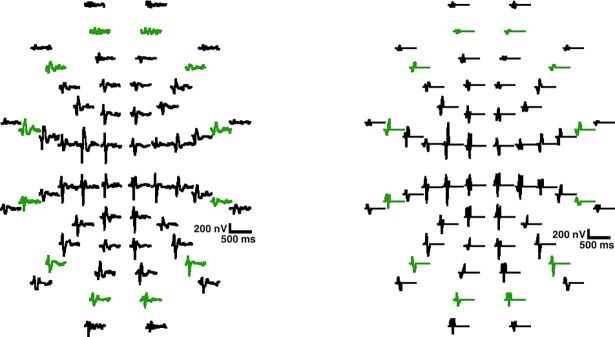
Example XDFT and XEMD.Ring 5 signals are colored in green.